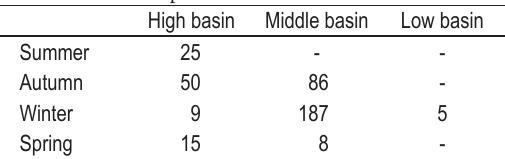
Table 1. Abundance of A. fasciatus per sampling site and season in the Garupá